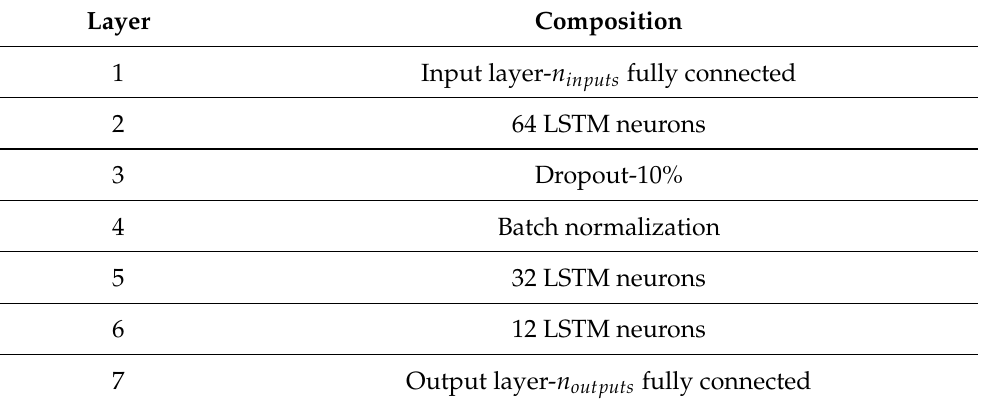
Table 9. Structure of Optimal LSTM